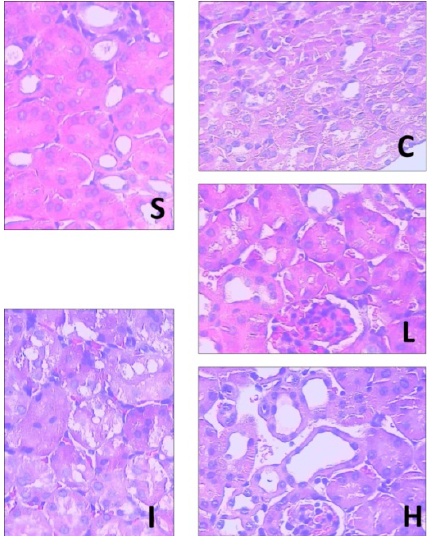
I: IIR group; C: NS group; L: RB1-30 group; H: RB1-60